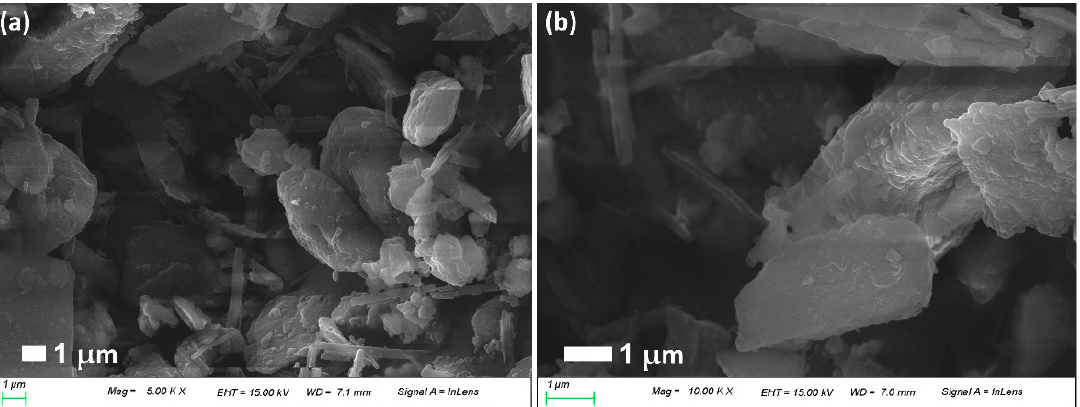
Figure 3. Antibiotics-incorporated/PDA-coated nephrite composites: ( a ) CIP-incorporated (CIP/dopamine/nephrite ratio = 0.2/1.0/1.0); ( b ) LEVO-incorporated (LEVO/dopamine/nephrite ratio = 0.2/1.0/1.0).